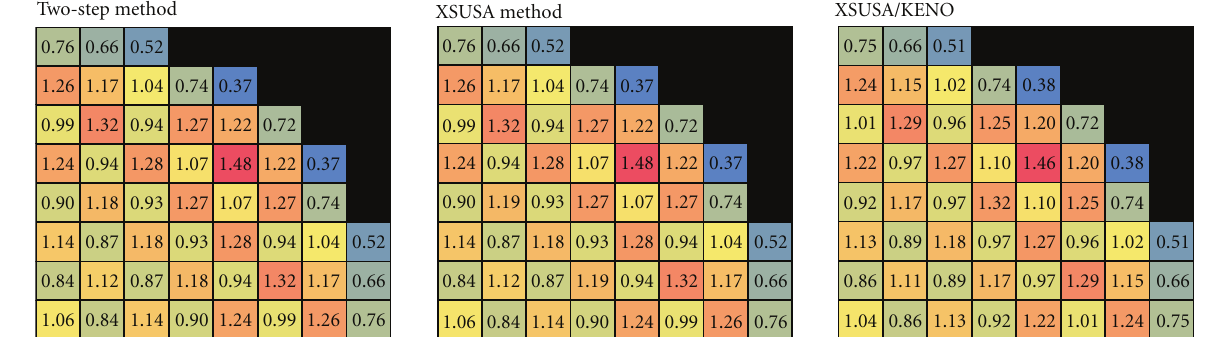
Figure 5: Mean power distribution calculated by the two-step and XSUSA methods along with the XSUSA/KENO reference. Values shown are calculated such that unity is the core average power. Quarter symmetry is displayed.